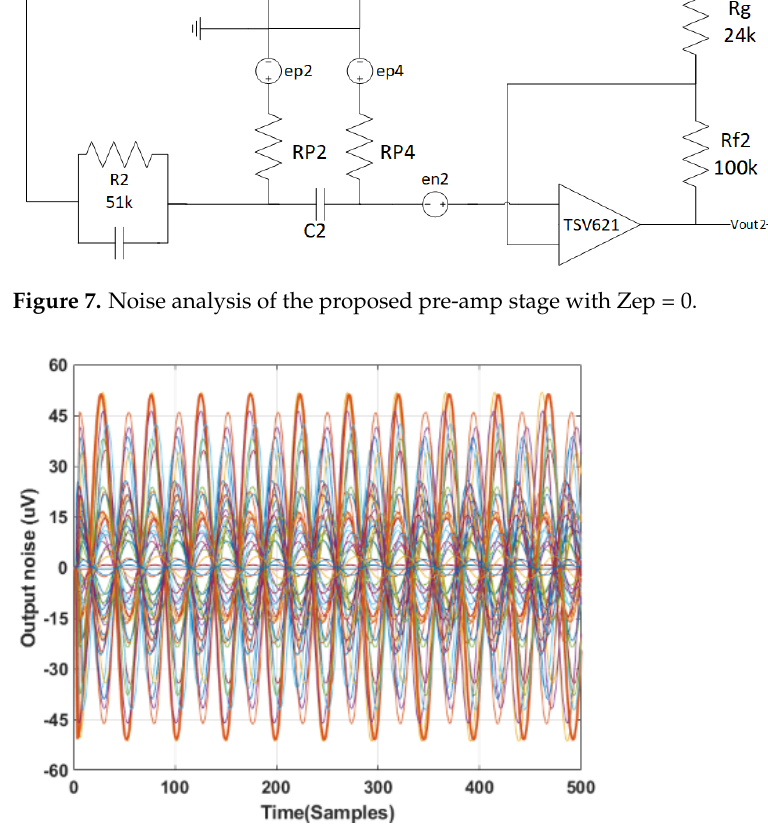
Figure 8. Monte Carlo simulations on pre−amplifier stage with 1% passive